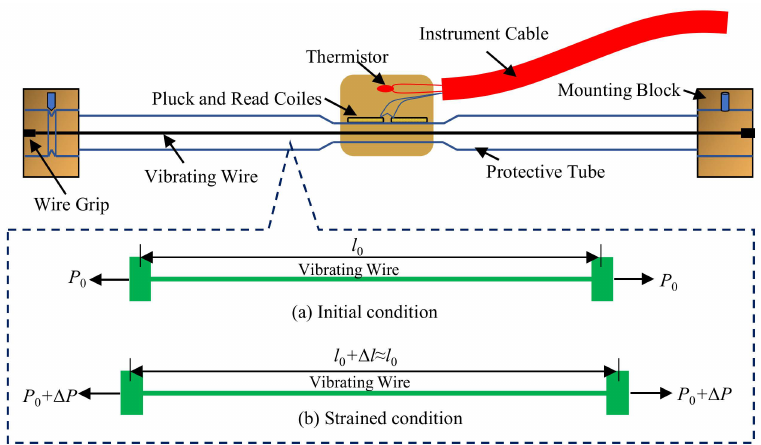
Figure 4. Schematic diagram of the internal details and measurement principle of the vibrating wire strain